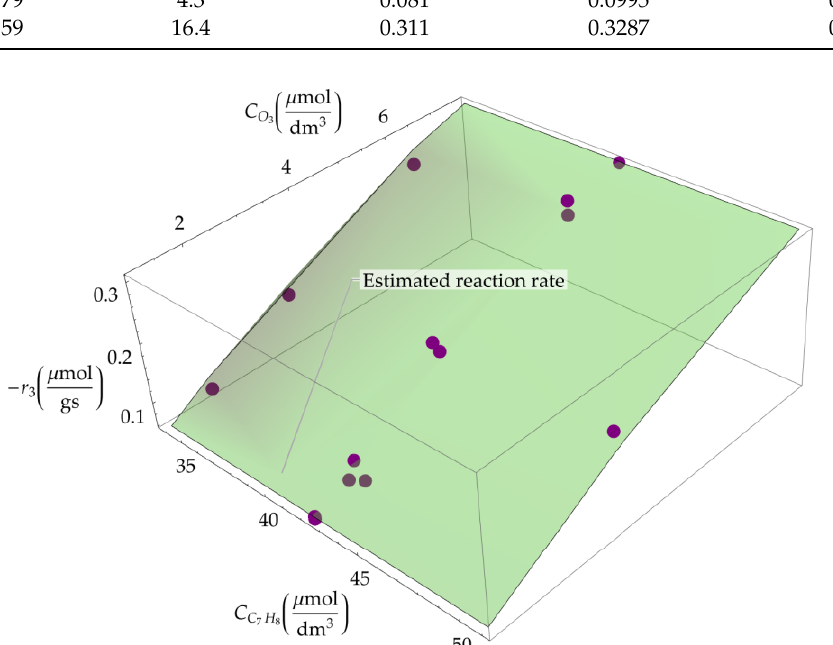
Figure 4. Fit between the proposed dsL-H kinetic reaction model and the experimental data reported in Table 2 for the catalytic ozonation of toluene using acidic surface-transformed natural zeolite, where the surface reaction between adsorbed species on adjacent active sites is the rate-determining step.